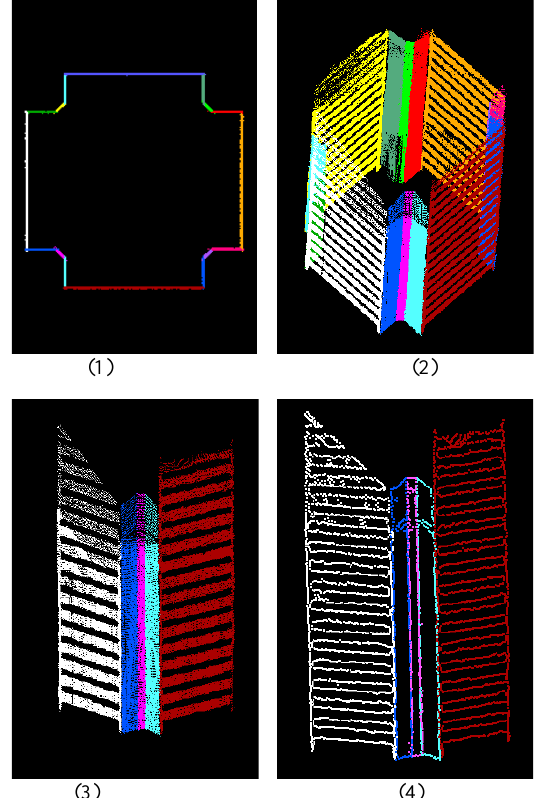
Figure 7. Results for planar regions segmented from point